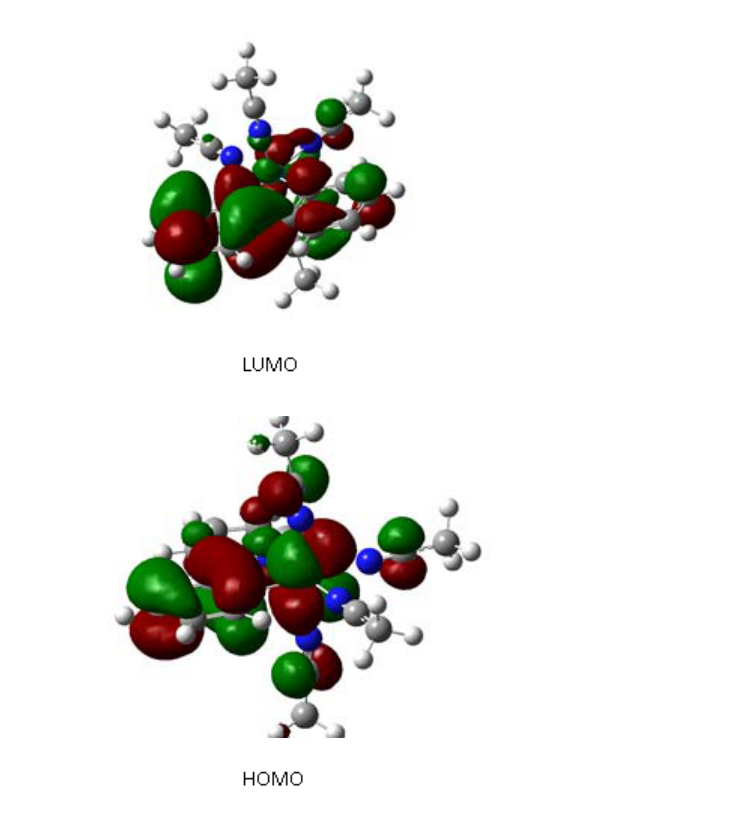
Figure 8. HOMO, LUMO set for yellow